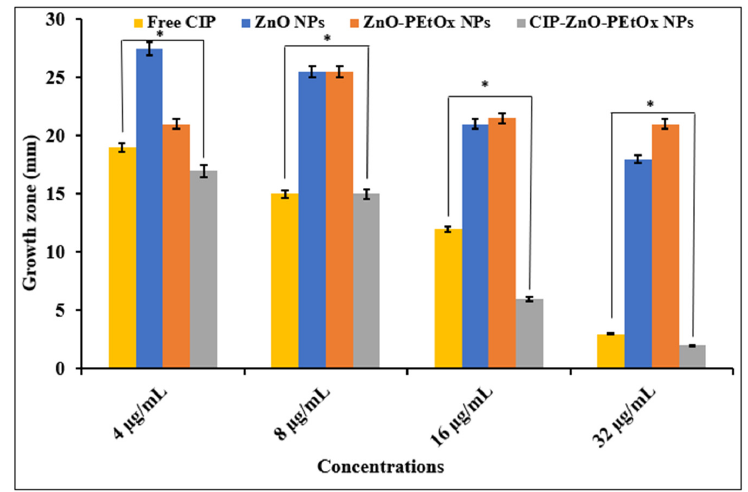
Figure 3. Bactericidal effects of free CIP, ZnO NPs, ZnO-PEtOx NPs, and combination of CIP-ZnO- loaded PEtOx NPs against S. aureus . p > 0.05 (*).